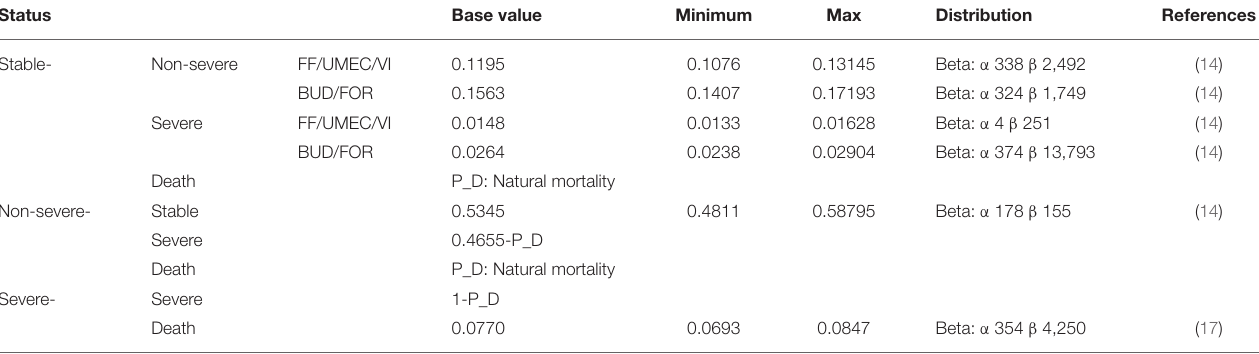
TABLE 3 | Transition